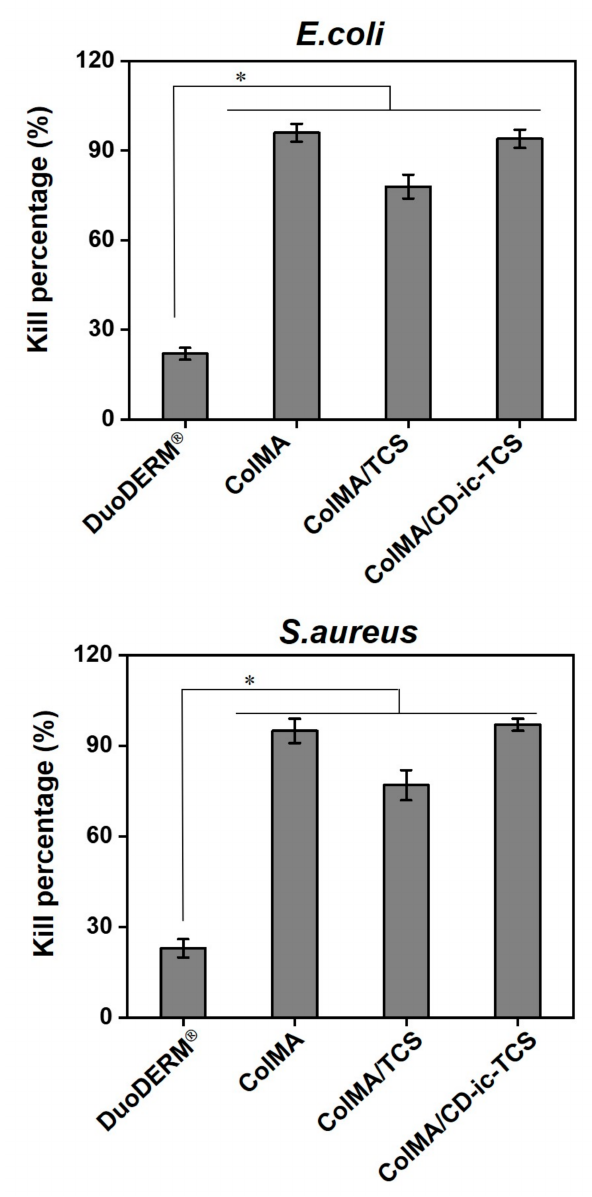
Figure 7. Antibacterial activity of DuoDERM ® , ColMA, ColMA/TCS, and ColMA-CD-ic-TCS against E.coli and S. aureus . ColMA—methacrylated collagen; ColMA/TCS—triclosan (TCS) incorporated ColMA; ColMA/CD-ic-TCS—HP- β -CD/TCS complex incorporated ColMA. This experiment was performed in triplicate ( n = 3). Results were expressed as mean ± standard deviation (* p <